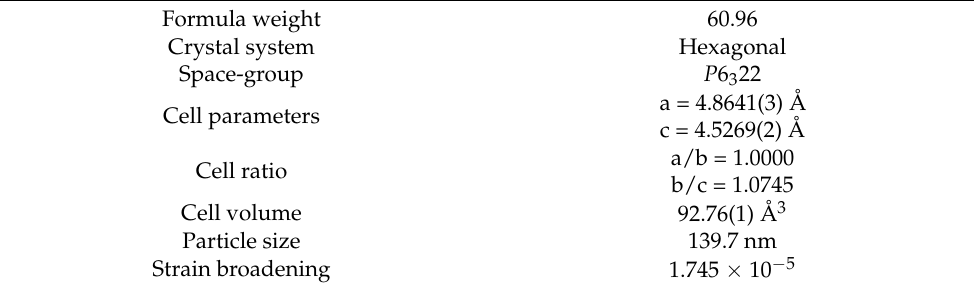
Figure 1. The powder XRD spectrum and the refined structure information of the sample. The black line represents the original experimental data, and the red circles represent the fitting results after Rietveld; ball-and-stick model of the crystal unit cell viewed from different directions. Table 1. Crystal structure information.